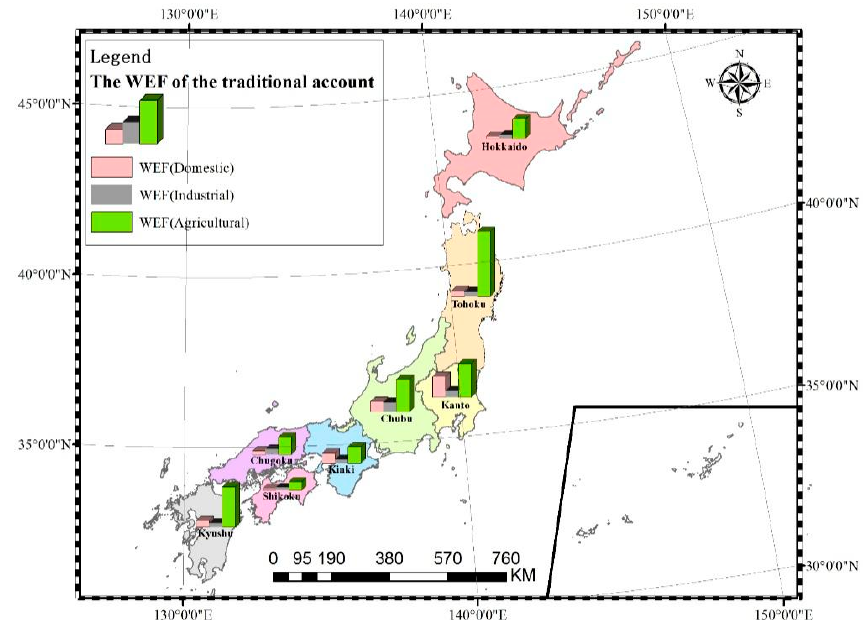
Figure 5. The WEF of traditional account in different administrative divisions of Japan in 2020.